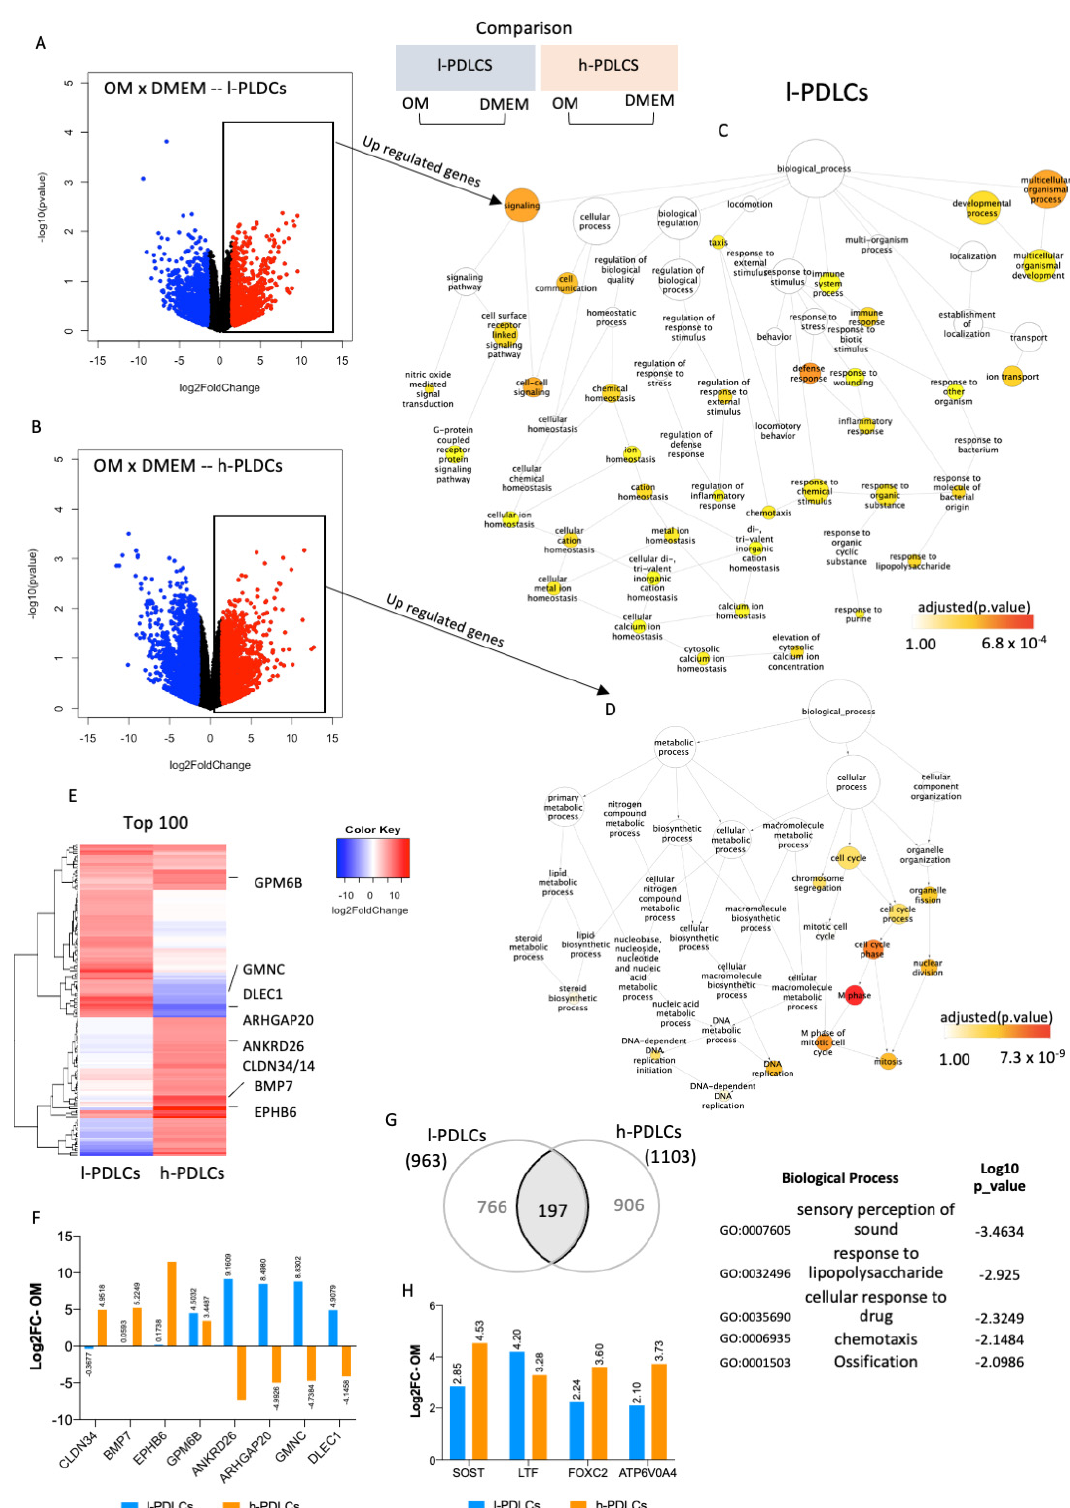
Figure 4. Transcriptional changes in PDLCs with distinct osteogenic potential in response to osteogenic stimulation. Both PDLC populations were cultured in osteogenic media for 10 days after which RNA was extracted for RNA-seq and the results compared to the respective controls (cells cultured in DMEM). ( A , B ) Differential gene expression determined by log2FoldChange between basal (DMEM) and stimulated (OM) conditions in l-PDLCs ( A ) and in h-PDLCs ( B ). The genes